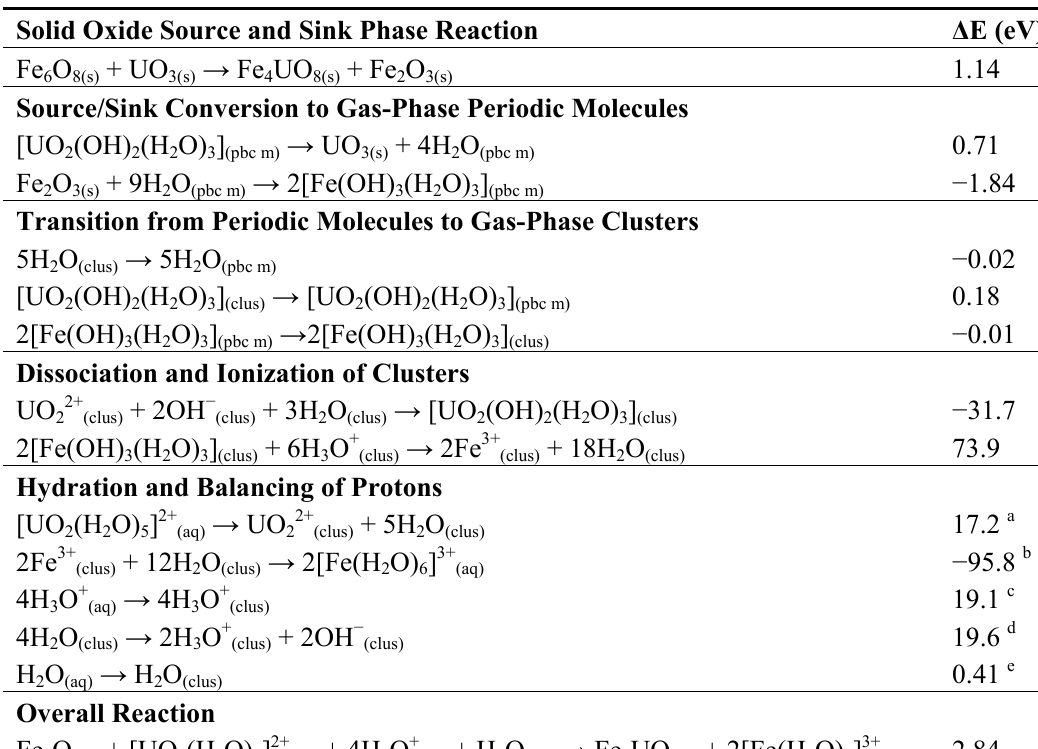
Table A2. U 6+ incorporation into octahedral Fe 3+ site of magnetite (Fe balanced by octahedral Fe 3+